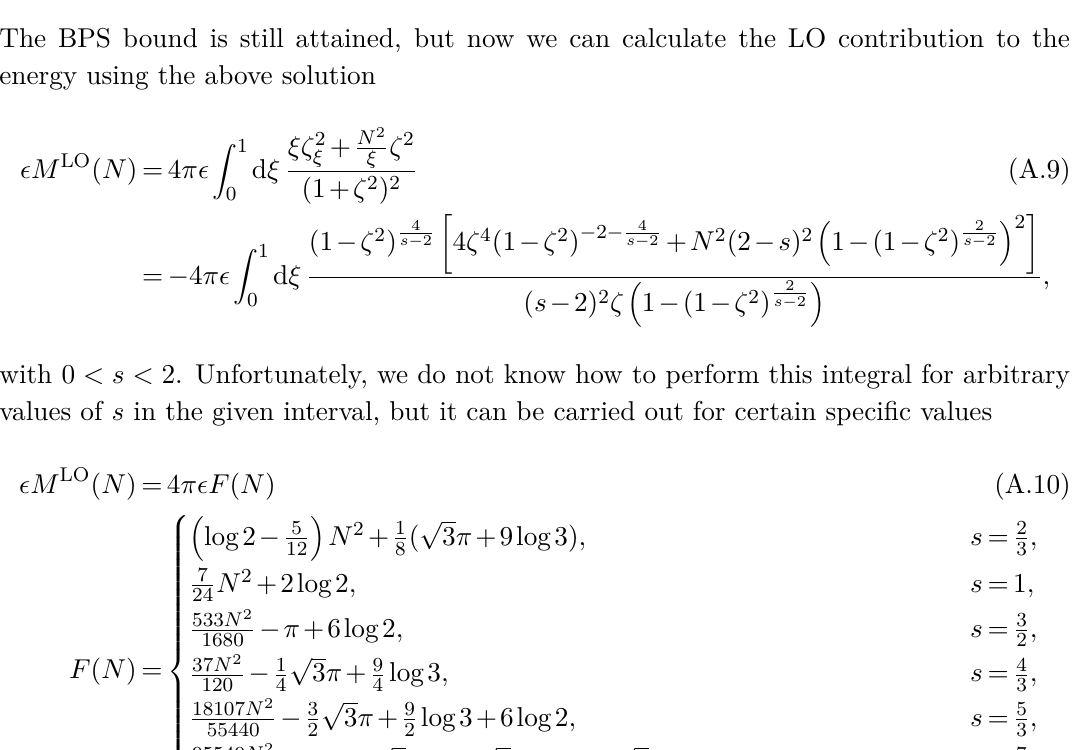
Figure 23 . The leading-order mass correction function F ( N ) = M LO ( N ) / 4 π as function of N for various values of s of the potential (A.2). Clearly, in all cases, the energy per N is smaller for N = 2 than for N = 1